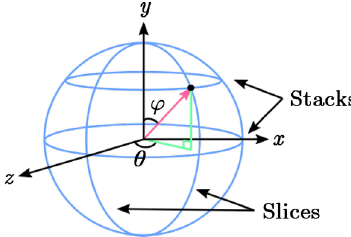
Fig. 2 Direction vector using spherical coordinates.